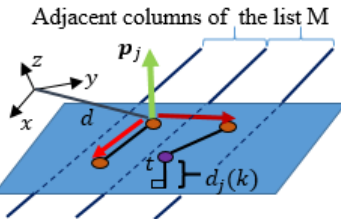
Figure 18. Initialization of a prototype plane with points of two unclassified line segments of adjacent columns of the list M with respect to the orthogonal distance to the